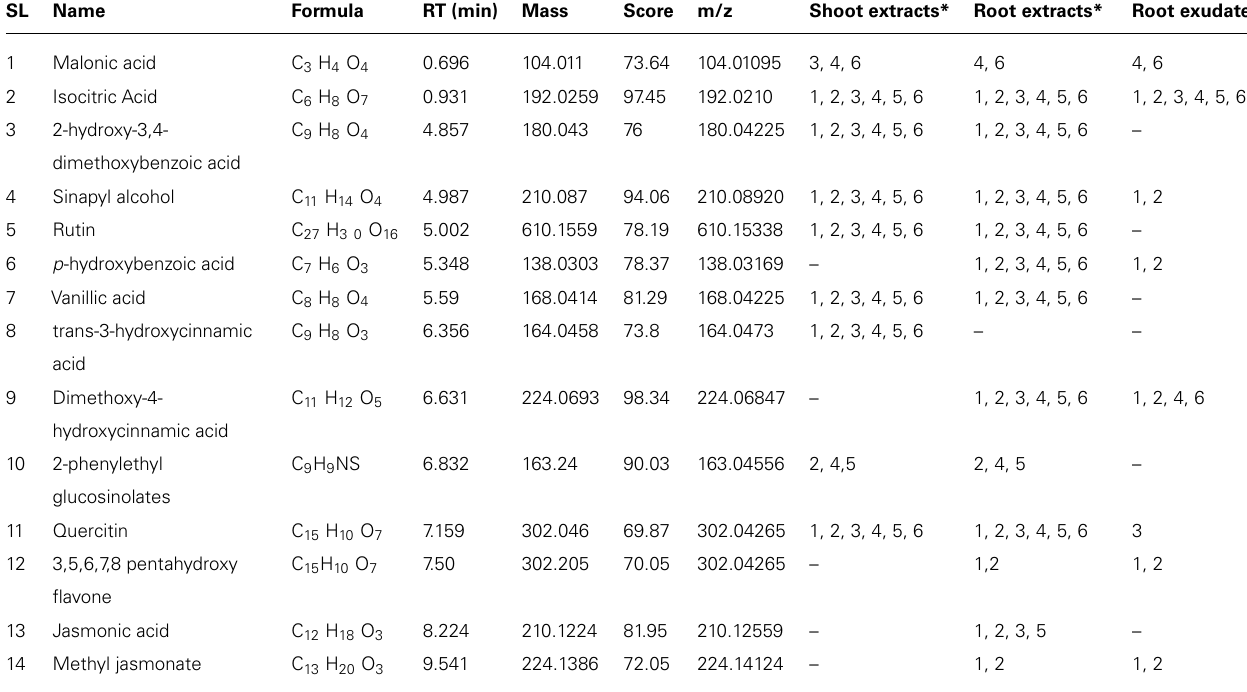
Table 3 | Phytochemicals identified in shoot and root extracts and root exudates of six canola genotypes using LC-QTOF-MS in negative mode and matched with data from two data bases.